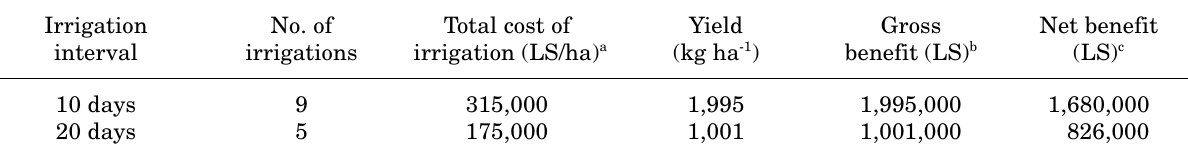
Table 5. Economic benefit obtained by irrigation in controlling the spread of chickpea stunt incidence in chickpea during the 1999–2000 growing season. Irrigation No. of Total cost of Yield Gross Net benefit interval irrigations irrigation (LS/ha) a